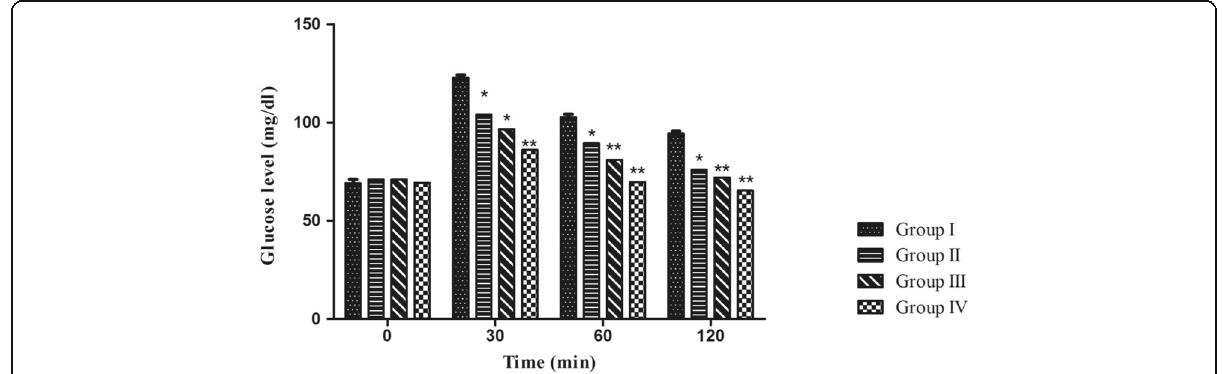
Fig. 3 Effect of ethanolic extract of C. azarolus var. eu- azarolus leaves and 3 β -O acetyl ursolic acid on glucose tolerance test, * p < 0.01, ** p < 0.001. Group I received 2 g/kg glucose only. Groups II and III received 250 and 500 mg/kg of the plant extract respectively, and group IV received 3 β -O acetyl ursolic